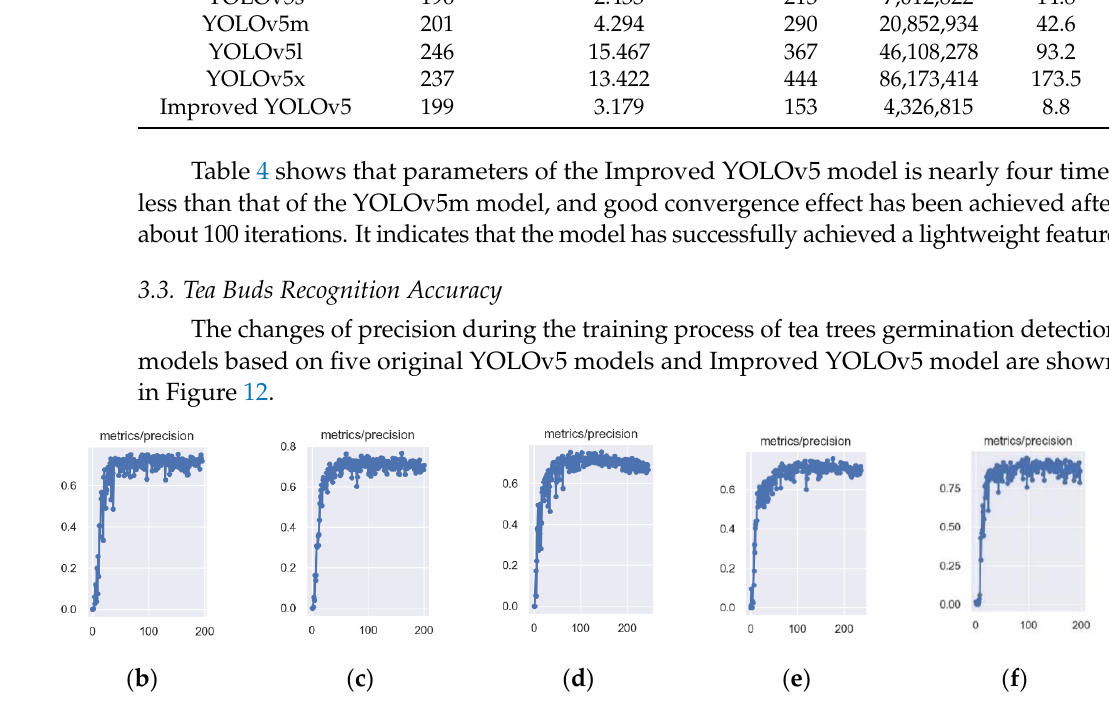
Figure 12. The changes of precision of different YOLOv5 models: ( a ) YOLOv5n; ( b ) YOLOv5s; ( c ) YOLOv5m; ( d ) YOLOv5l; ( e ) YOLOv5x; ( f ) Improved YOLOv5.